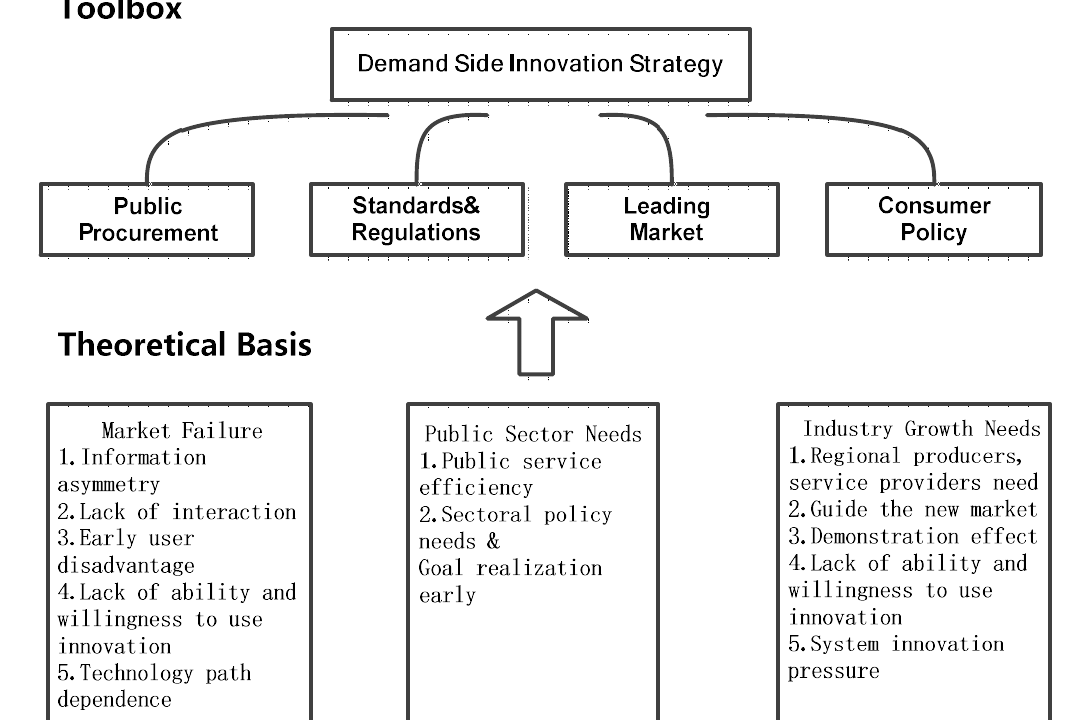
Figure 4. Demand-side innovation policy schematic map.